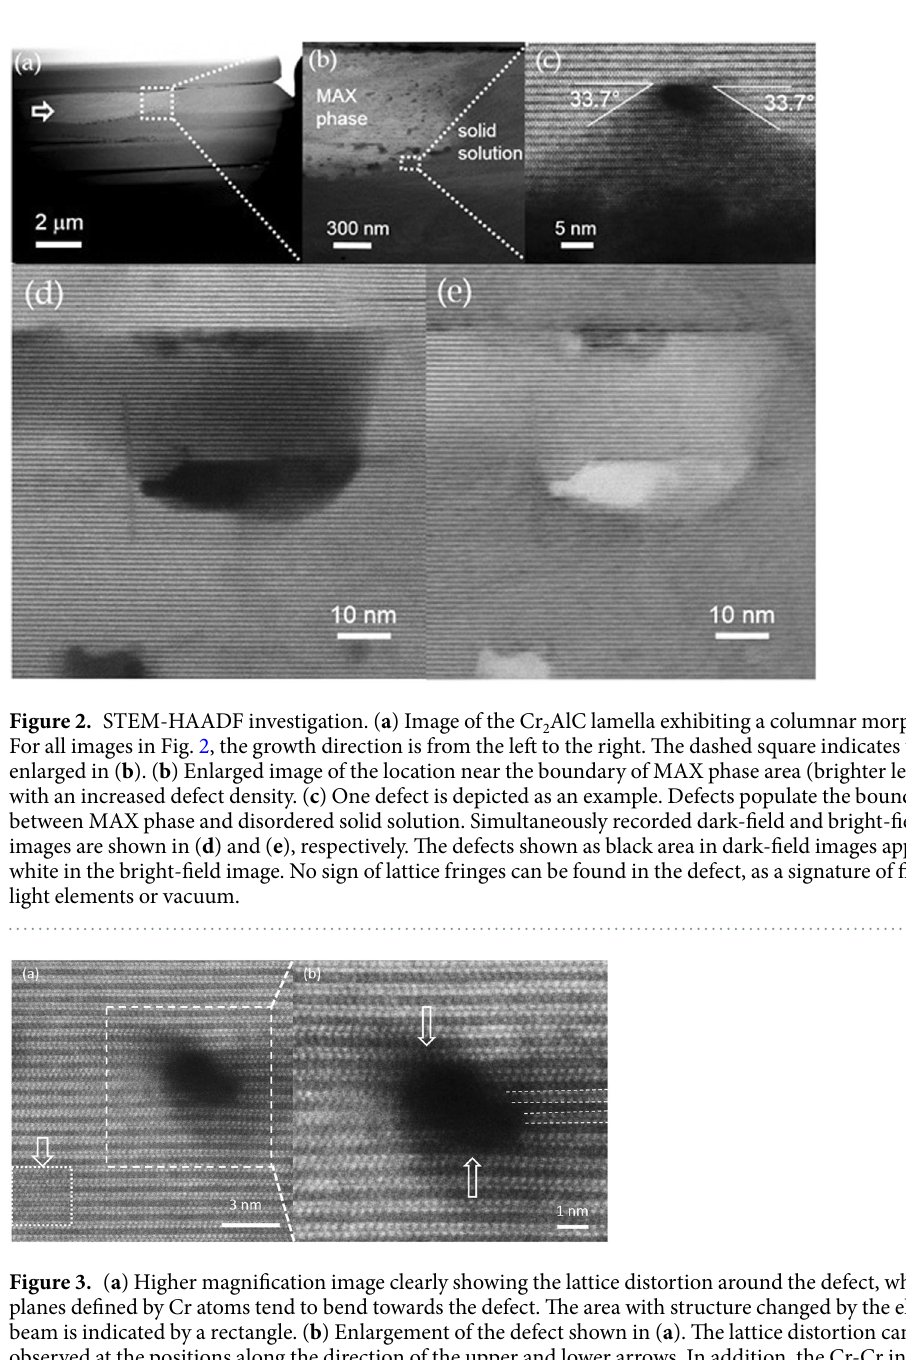
Cr-Cr interplanar distances are shortened, while the Cr-Al distances are increased compared to the position of atoms in the strain-free region of the specimen. Based on the difference in thermal expansion coefficient between Cr 2 AlC 25 and Al 2 O 326 the as deposited thin film is expected to exhibit a tensile stress state after cooling down from the deposition temperature. However, Ar ion bombardment 27 as well as bombardment with ions of the film form- ing species 28 are expected during thin film growth by HPPMS. It is well known that film grown in the presence of ion bombardment can exhibit compressive stress states 29 consistent with the lattice deformation around the defect observed in the STEM images shown in Fig. 3(a) and (b). More images of lattice distortion in the vicinity of defects are shown in Figure S1 of supplementary information. To exclude the artefacts of knock on damage from the 300 kV electron beam, we have focused the electron beam on a small region and observed the change of the atomic contrasts under the electron beam illumination, as indicated by a rectangle in Fig. 3(a). Since the defect popu- lation is high and is gradually increased from the MAX phase region to the solid solution region (Fig. 2a and b) and since some of the defects are located at the intersection of two symmetric crystal planes (Fig. 2c), it is